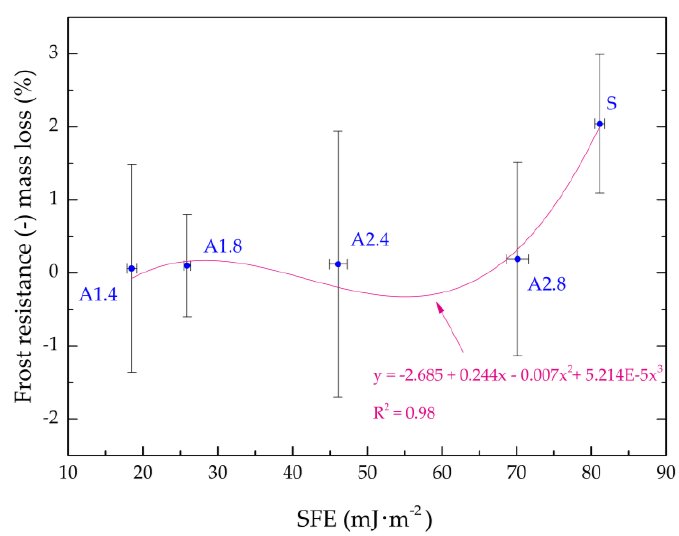
Figure 5. Correlation between SFE and frost resistance.